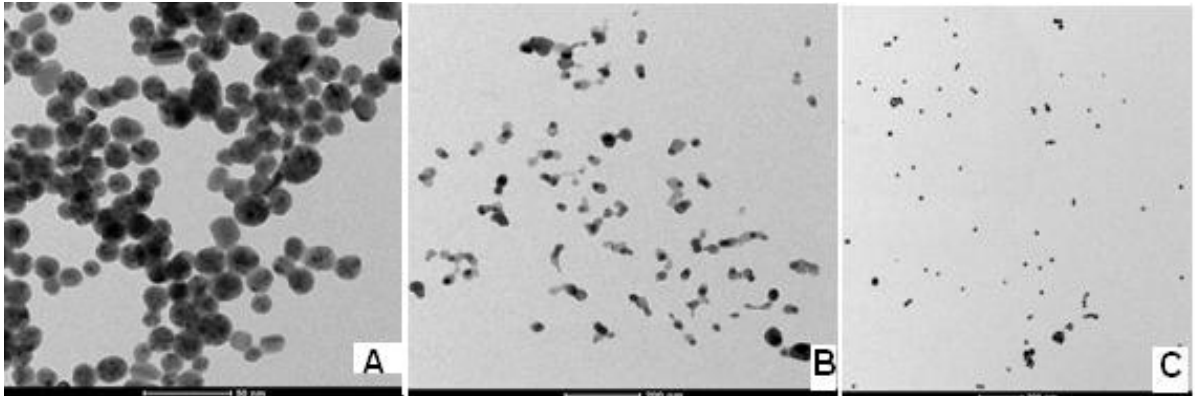
Figure 2 . TEM image of (A) Ag-Au bimetallic alloy nanoparticles, (B) Ag nanoparticles and (C) Au